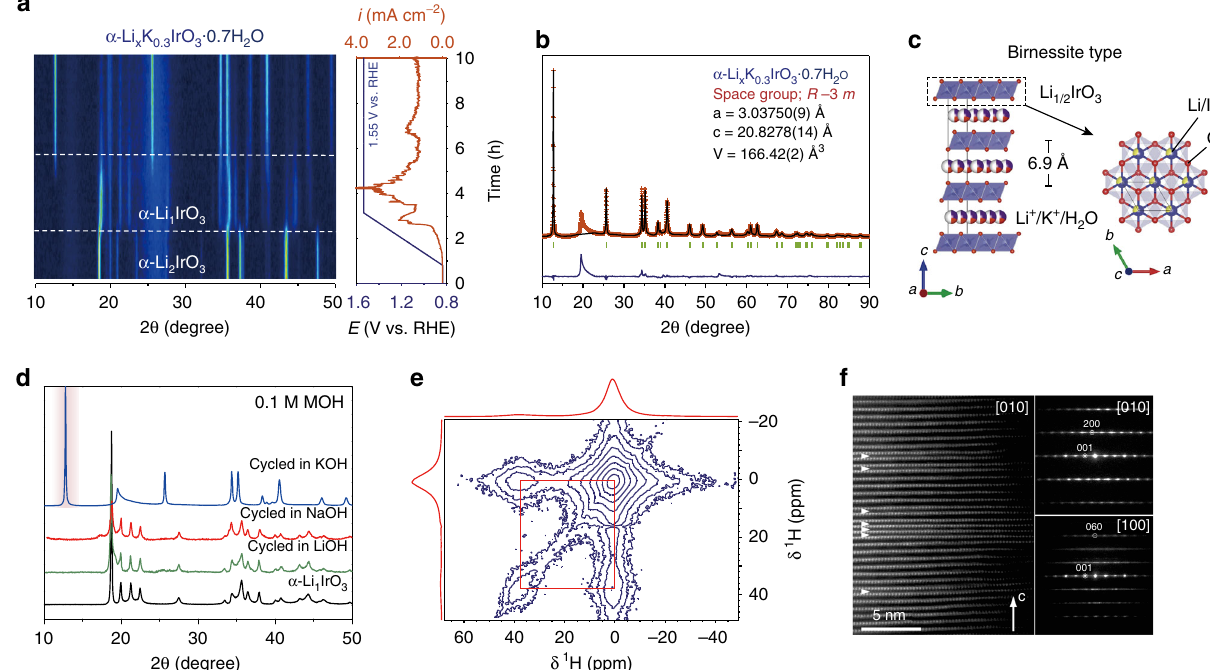
Fig. 3 Characterization of the hydrated K + -containing birnessite phase formed during exposure with KOH. a Operando XRD performed during the electrochemical oxidation in 0.1 M KOH solution of α -Li 2 IrO 3 from OCV (0.8 V) to 1.55 V vs. RHE at a scan rate of 0.1 mV s − 1 , and then hold for 10 h. b Rietveld analysis for the hydrated K + -containing birnessite phase, and c the corresponding structural model with K + cations and H 2 O molecules distributed between the honeycomb Li 1/3 Ir 2/3 O 2 layer. d XRD diffractograms collected for pristine α -Li 1 IrO 3 and after cycling in different alkaline solutions (LiOH, NaOH, and KOH). e 1 H 2D exchange spectroscopy (using a 10 ms mixing time) of the birnessite between interlayer H 2 O (0.9 ppm peak) and structural hydroxide groups (37.8 ppm peak). f Electron diffraction patterns (right) and HAADF-STEM image (left) of the birnessite phase. The O3 structure with d 001 ≈ 6.2 Å interleaves with lamellas of the O1 structure with d 001 ≈ 4.5 Å (marked with